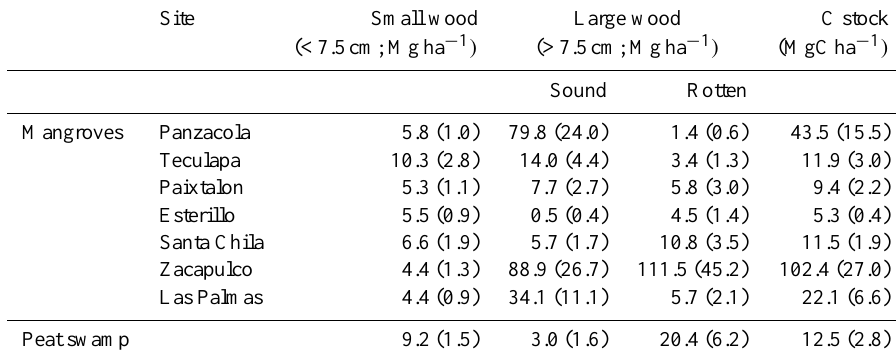
Table 4. Biomass (Mgha − 1 ) and C stocks (MgCha − 1 ) of downed wood in La Encrucijada Biosphere Reserve. Wood debris was calculated separately for small wood (diameter >2.5 and <7.5cm), and large sound and large rotten wood (diameter >7.5cm). Values are shown as mean (standard